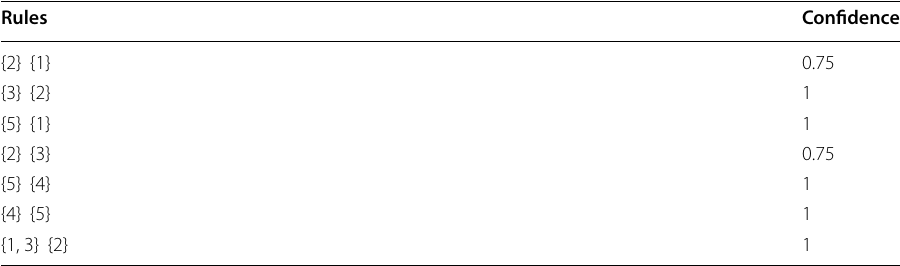
Table 10 Association rules generated